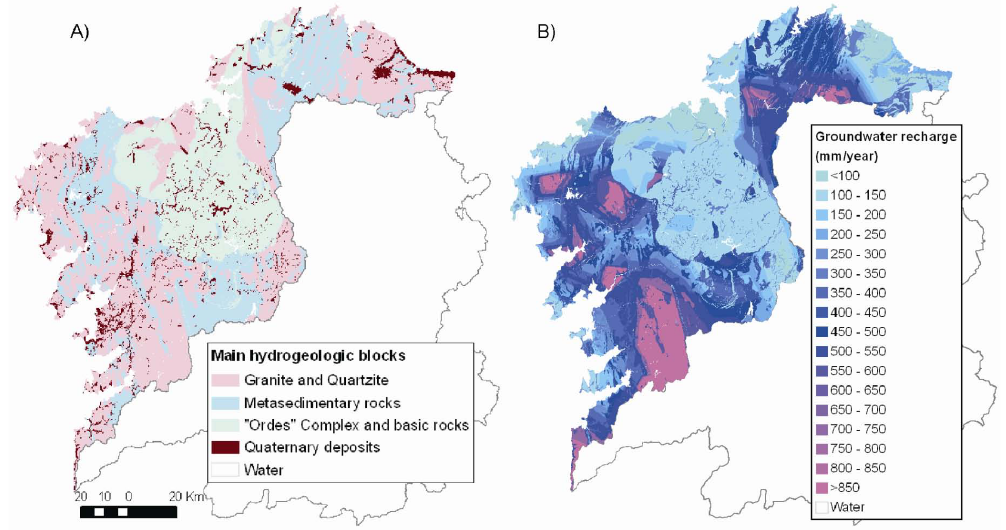
Fig. 9. Main geological units (A) considered for extrapolation of water balance models results and groundwater recharge (B) obtained for Galicia-Costa district by a GIS tool as a function of precipitation and